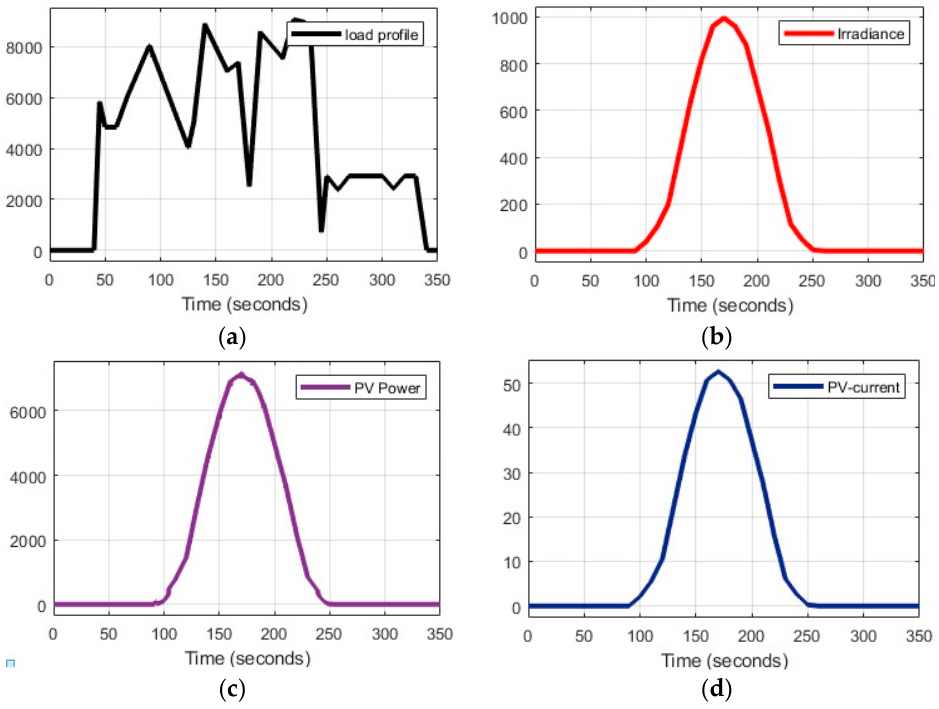
Figure 16. ( a ) Load profile, ( b ) irradiance, ( c ) PV power, ( d ) PV current. Table 7. Simulation stages and its